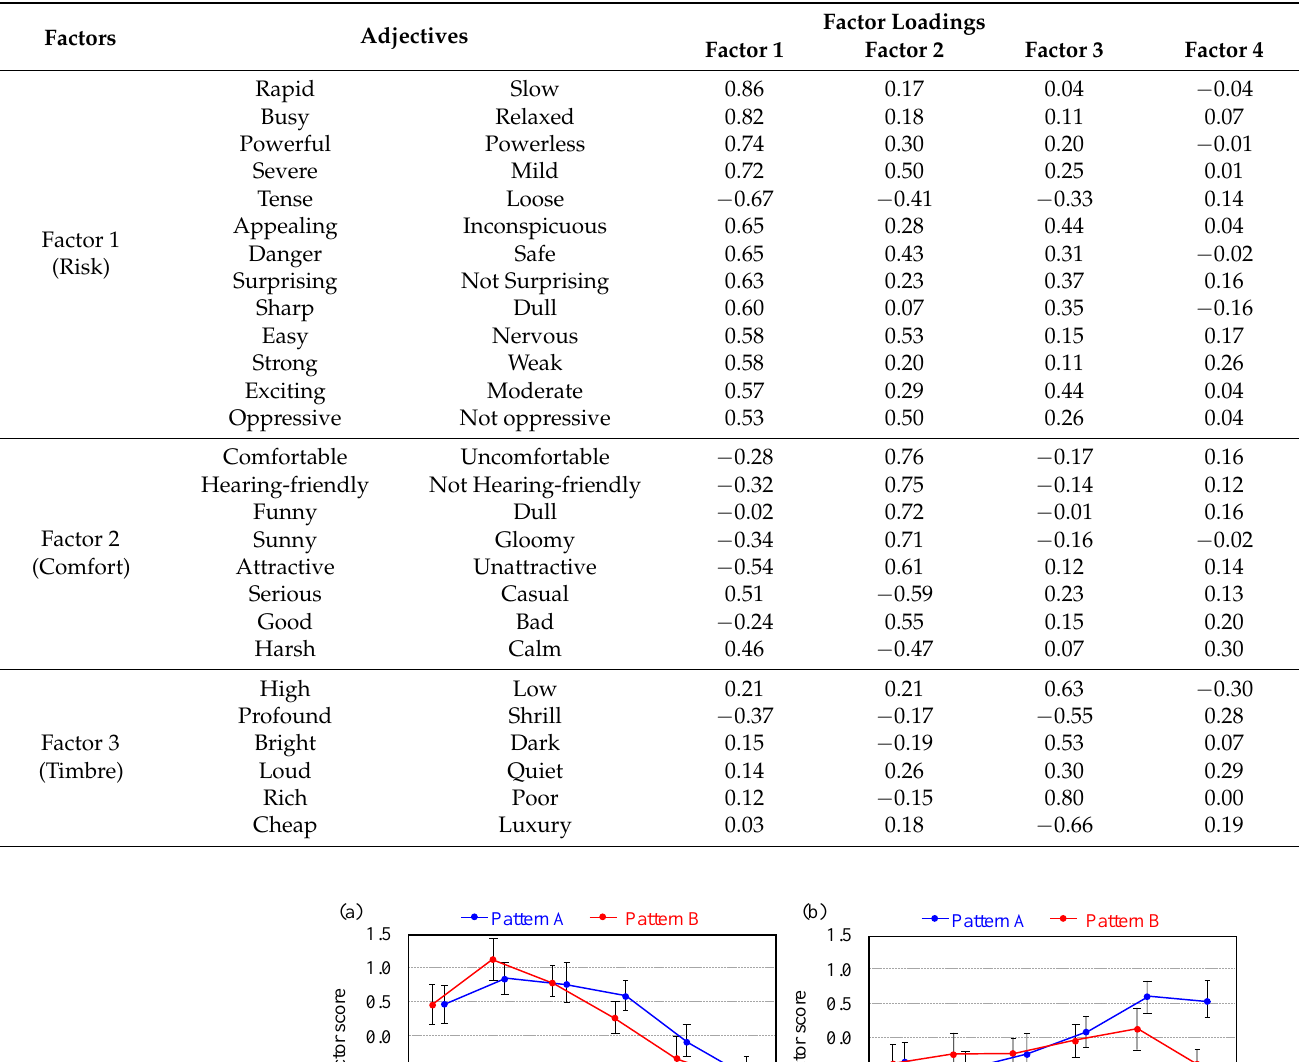
Table 6. Experimental results of factor analysis in case of Phase 2.